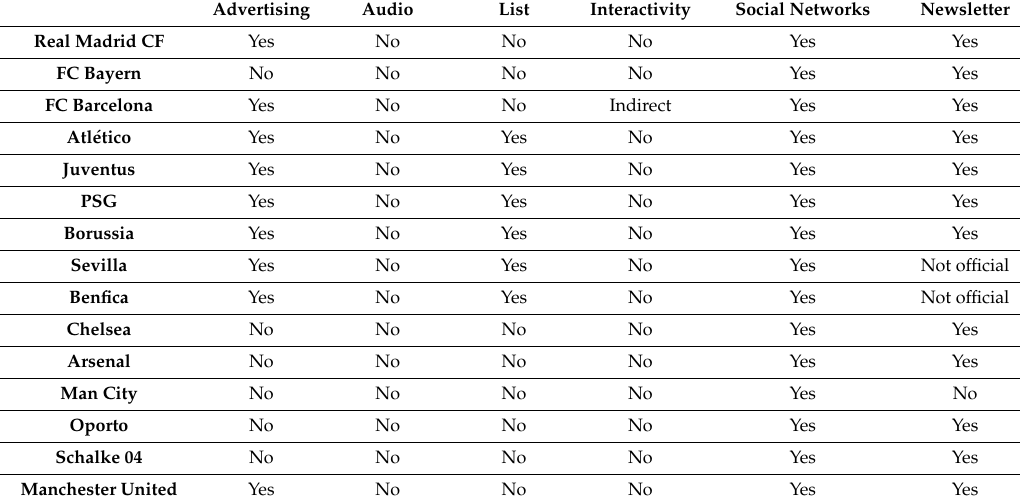
Table 6. Use of multimedia and interactive